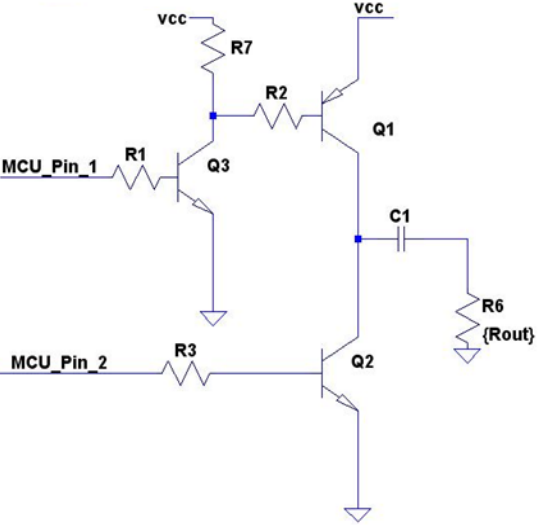
Figure 5. Digitally controlled push-pull B-class amplifier